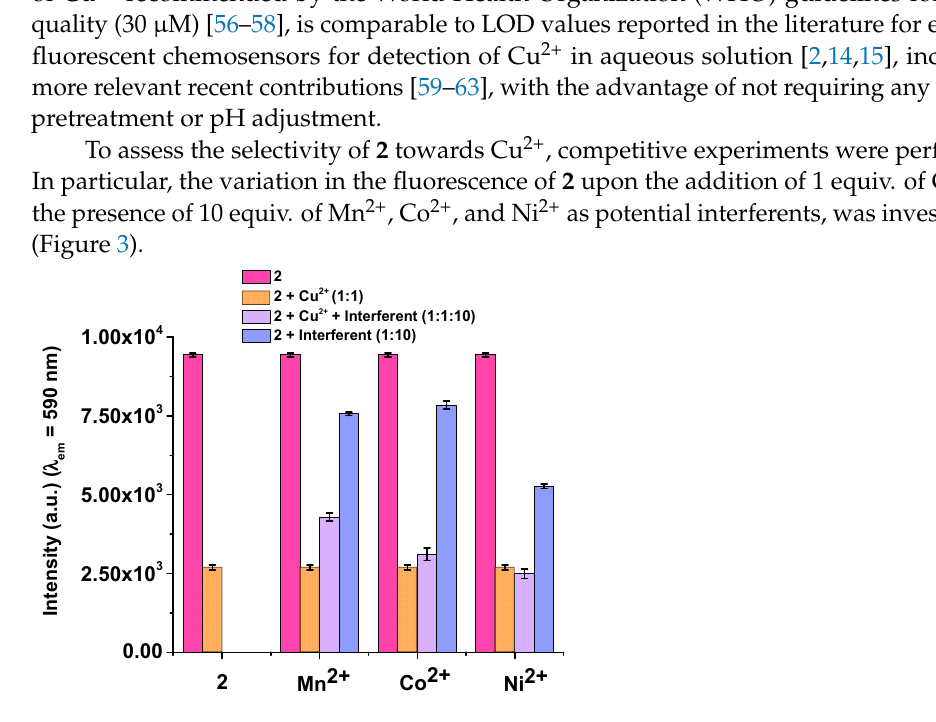
Figure 3. Fluorescence emission intensity of 2 at 590 nm (40 µM solution in MeCN, λ exc = 397 nm; fuchsia bars); upon the addition of 1 equiv. of Cu 2+ (light orange bars); upon the addition of 1 equiv. of Cu 2+ in the presence of 10 equiv. of the interferent (lilac bars). The fluorescence emission intensity of 2 at 590 nm upon the addition of 10 equiv. of the interferent is represented with bright yellow bars.